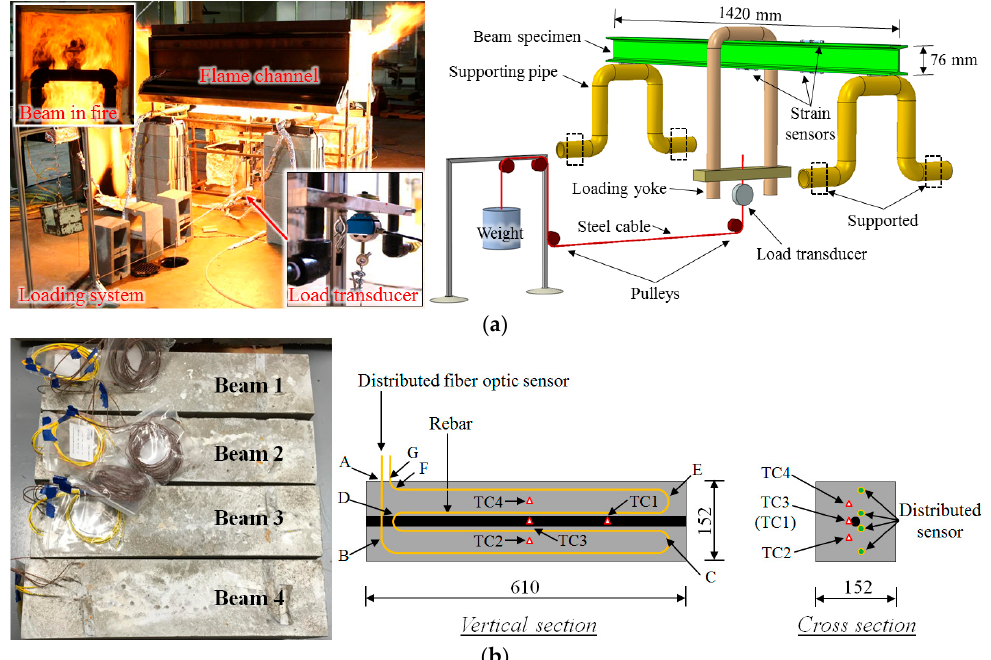
Figure 11. Applications of distributed fiber optic sensors in structural fire testing of: ( a ) Steel beam [125], and ( b ) reinforced concrete beam [126].